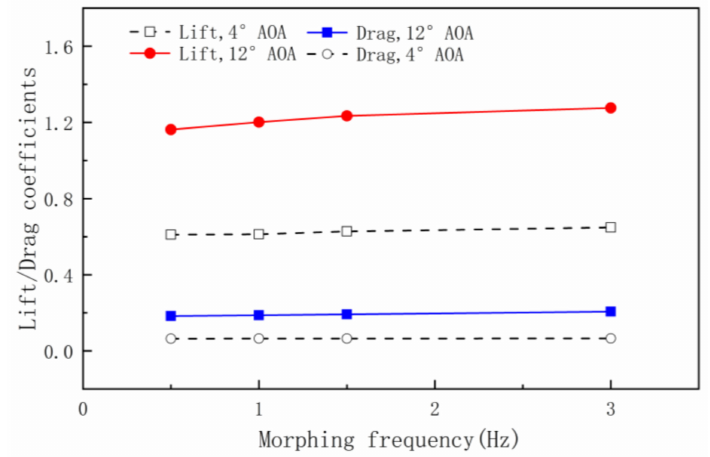
Figure 11. Comparisons of lift/drag coefficients with morphing